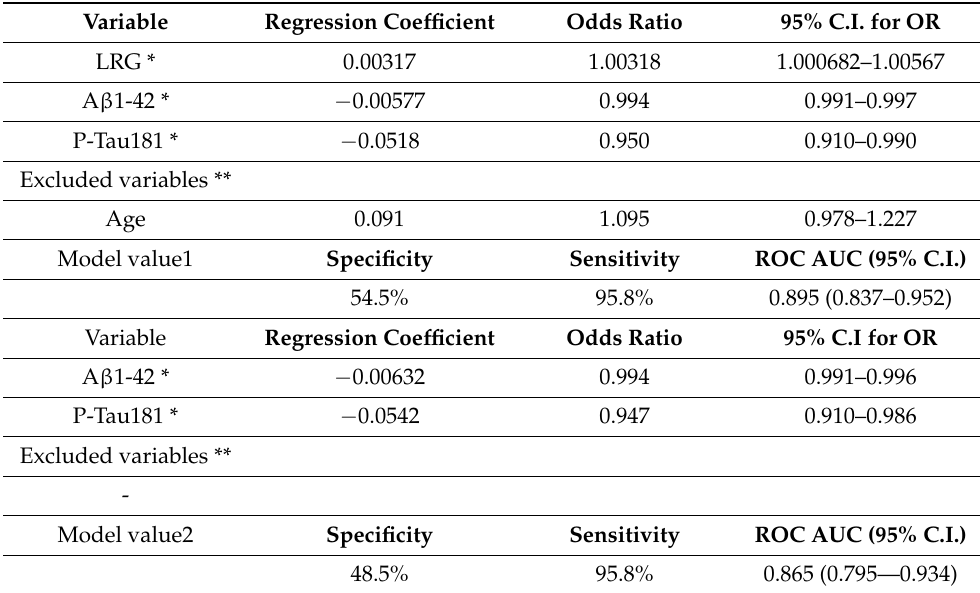
Table 2. Binary logistic regression results for a model with and without LRG.